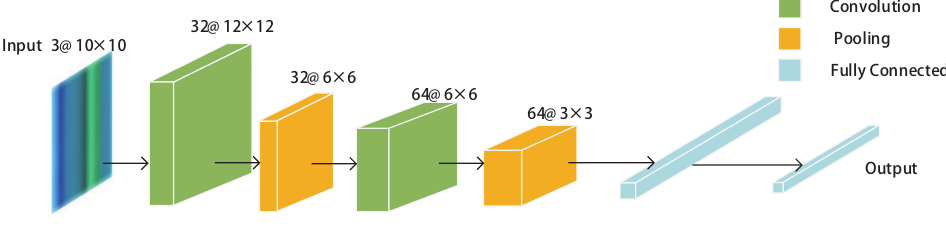
Figure 5. System design of the LeNet5 CNN network